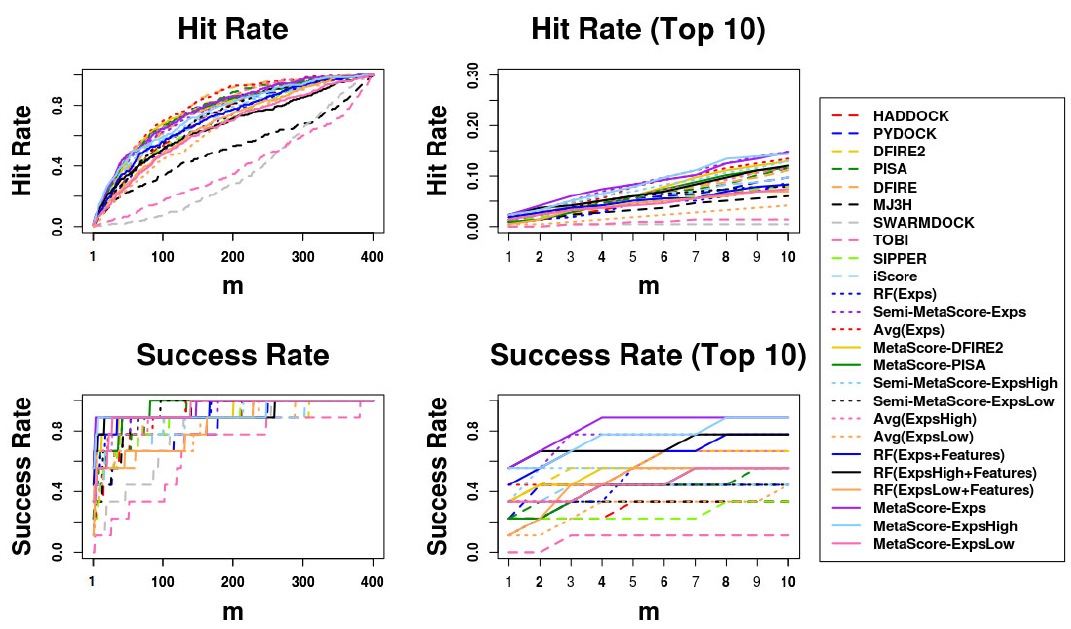
Figure 2. Success rates and hit rates plotted against the top m conformations for original methods, machine ‐ learning ‐ based scoring methods combined with each original method, the averaging method of the Expert Committee’s scores, and machine ‐ learning ‐ based scoring method using the Expert Committee’s scores combined with the averaging method of their scores using BM5 decoy set. The Expert Committee has three groups, the high ‐ ranked group (ExpsHigh), the low ‐ ranked group (ExpsLow), and the group of entire members (Exps). There are four panels: (Top left) hit rates for conformations of top m ranging from 1 to 400; (Top right) hit rates for conformations of top m ranging from 1 to 10; (Bottom left) Success rates for conformations of top m ranging from 1 to 400; (Bottom right) success rates for conformations of top m ranging from 1 to 10. Table 5. Performance comparison of scoring methods including original methods, RF classifier var ‐ iants, averaging method variants, MetaScore variants, and Semi ‐ MetaScore variants using BM5 de ‐ coy set, which is a set of decoys generated by HADDOCK from the newly added docking cases to the protein–protein docking benchmark version 5.0.